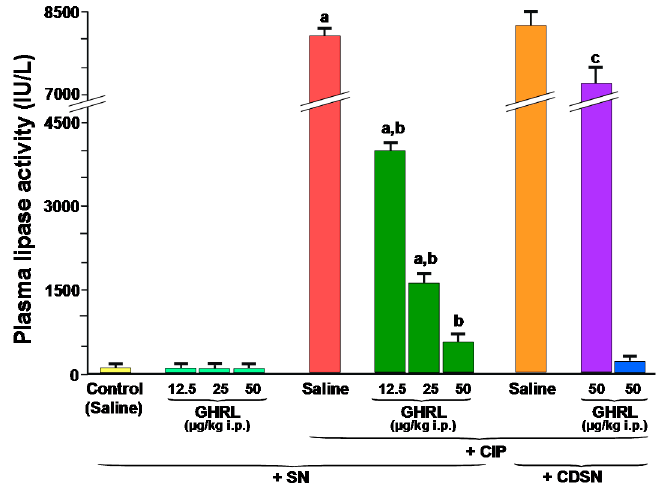
Figure 4. Effect of saline or ghrelin (GHRL) given intraperitoneally at a dose of 12.5, 25 or 50 μ g/kg and cerulein-induced pancreatitis (CIP) on plasma activity of lipase in sensory nerves-intact rats (SN) or rats with capsaicin deactivation of sensory nerves (CDSN). a p < 0.05 compared to the control group with intact sensory nerves and without induction of CIP ; b p < 0.05 compared to sensory nerves-intact rats with CIP pretreated with saline; c p < 0.05 compared to sensory nerves-intact rats pretreated with GHRL at a dose of 50 μ g/kg prior to CIP. Mean ± SEM from values obtained from 10–15 rats in each experimental group.